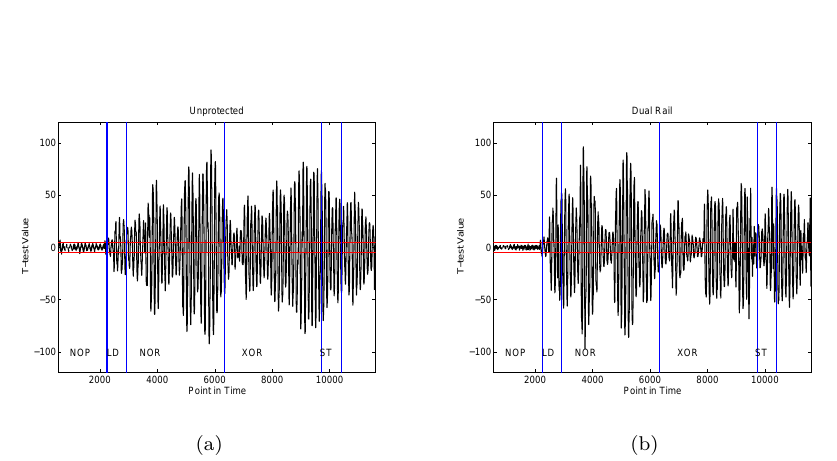
Figure 5: TVLA on unprotected and software dual-rail. The red lines indicate the upper and lower limits of the TVLA threshold ( ± 4.5).